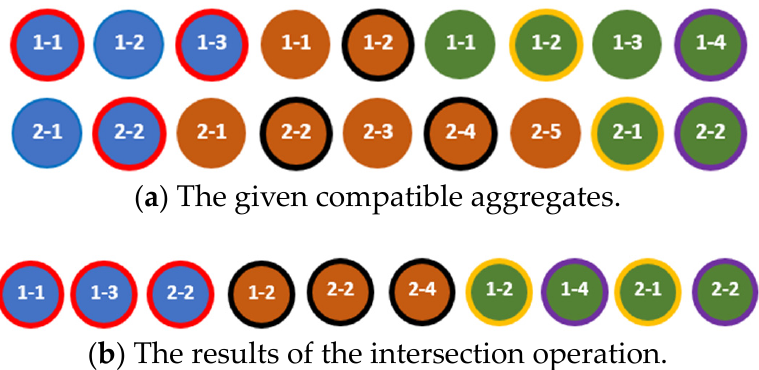
( a ) The given quasi-compatible aggregates. ( b ) The results of the intersection operation. Figure 7. An example of applying the intersection operation to two quasi-compatible aggregates. The exclusive intersection of the aggregates 𝐴 (cid:2869) and 𝐴 (cid:2870) is the aggregate 𝑅 (cid:3411) , which contains only components of the 𝐴 (cid:2869) aggregate that are common in these aggregates and are ordered according to the rule de fi ned in [18]. This rule can be presented as the algo- rithm for fi nding a result of the exclusive intersection of two aggregates as shown in List- ing 4. Listing 4: Algorithm of the exclusive intersection operation for two aggregates. Input: aggregates 𝐴 (cid:2869) and 𝐴 (cid:2870) Output : aggregate 𝑅 if 𝐴 (cid:2869) ≑ 𝐴 (cid:2870) then for 𝑖 = 1: 𝑁 do for 𝑘 (cid:3036) = 1: 𝑛 (cid:3036)(cid:2869) do if 𝑎 (cid:3038) (cid:3284) (cid:2869),(cid:3036) ∈ 𝐴 (cid:2870)(cid:3036) 𝑟 (cid:3038) (cid:3284) = 𝑎 (cid:3038) (cid:3284) (cid:2869),(cid:3036) end end end else if 𝐴 (cid:2869) ≗ 𝐴 (cid:2870) then 〈𝑟 (cid:3038) (cid:3284) 〉 (cid:3038) (cid:3284) (cid:2880)(cid:2869)(cid:3041) (cid:3284)(cid:3117)